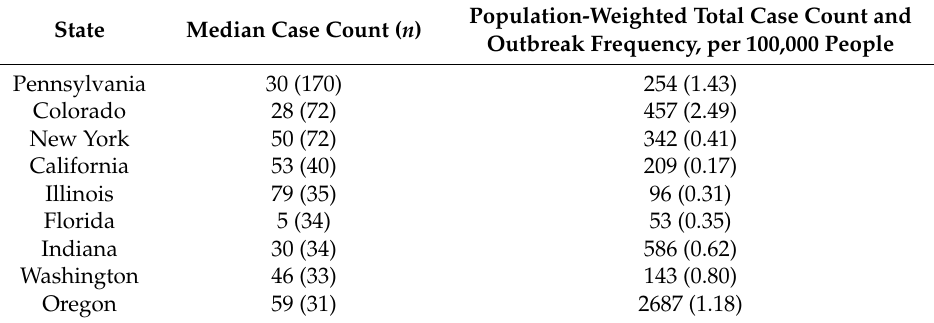
Table 4. Outbreak health data by U.S. state (top nine states).